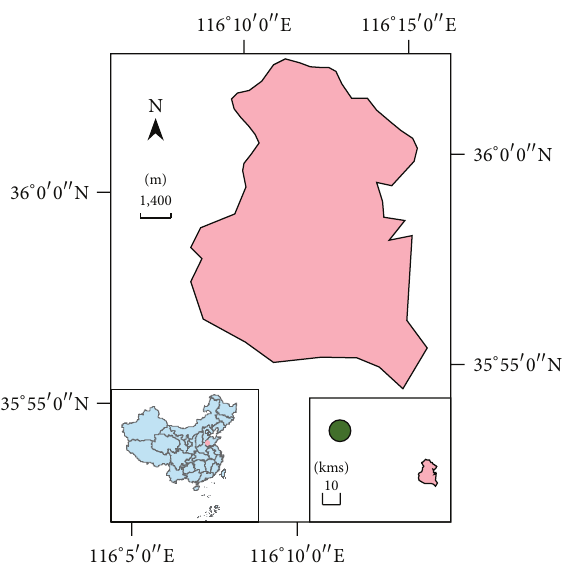
Figure 1: The location and shape of Dongping Lake in China.